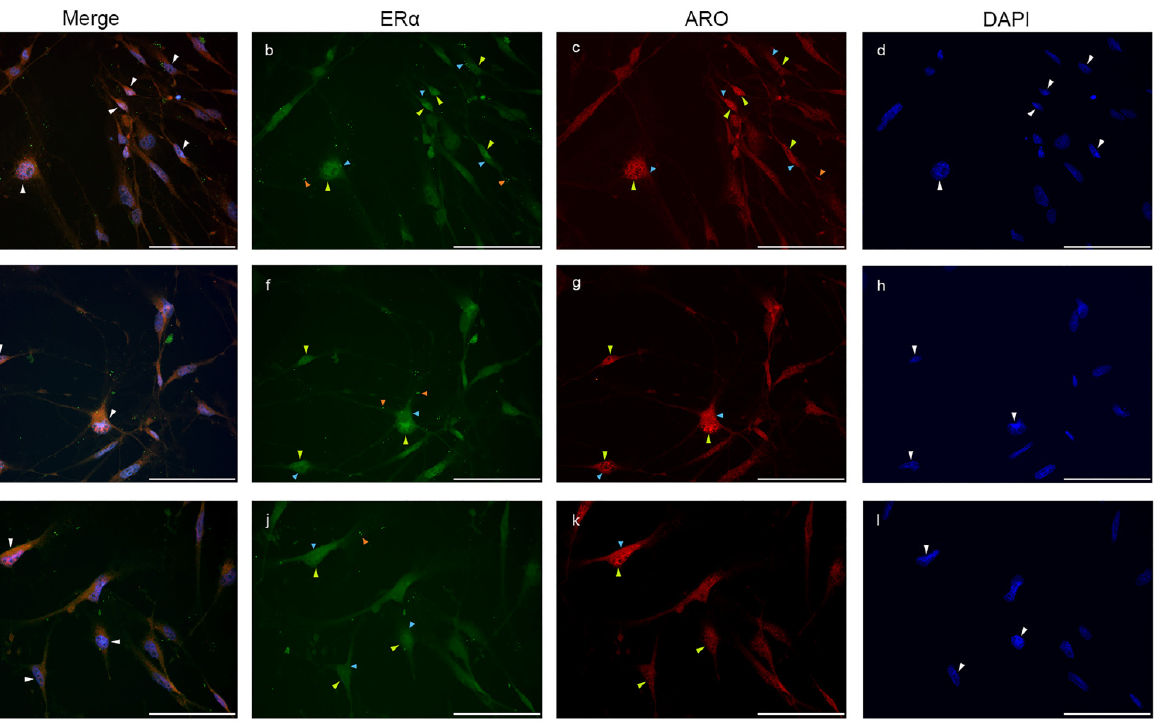
Figure 8. Nuclear aromatase expression overlaps with nuclear ER α signal. Double immunostaining with ER α (green) and Aro (red) in glia culture ( a – l ) shows that nuclear Aro signals colocalize with nuclear ER α ( a , e , i ; white arrowheads). Both Aro and ER α are strongly represented in the nucleus ( b , c , f , g , j,k ; yellow arrowheads) and also in the cytoplasm ( b , c , f , g , j , k ; blue arrowheads). ER α positive dots are also detectable in the processes ( b , f,j ; orange arrowheads). Scale bar: 100 μ m.